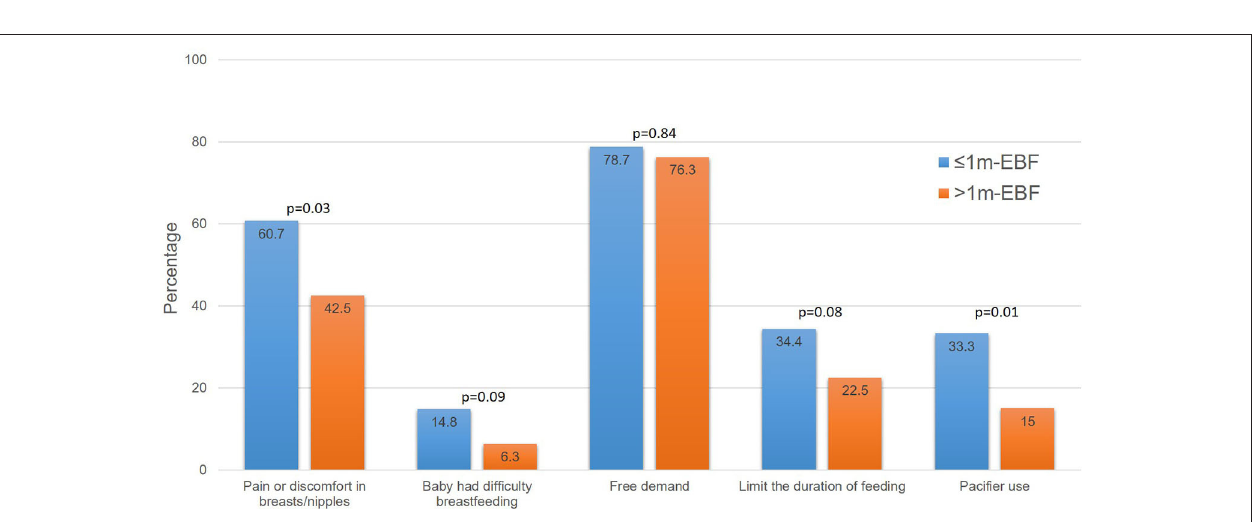
FIGURE 5 | Breastfeeding during early postpartum. Groups were compared using the chi-square